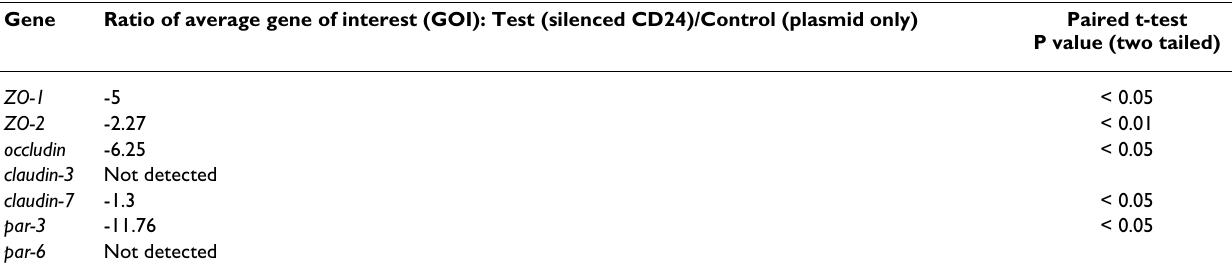
Table 2: Real-time quantitative RT-PCR analysis of changes in expression of genes encoding tight junction proteins in response to down-regulation of CD24